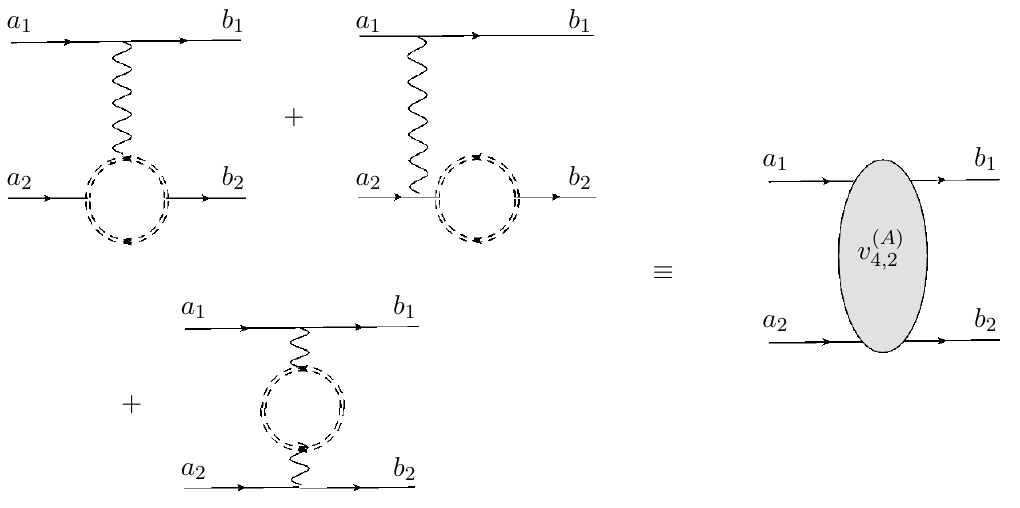
Figure 8 . Irreducible two-loop diagrams that correct the ’ propagator in the di(cid:11)erence theory.